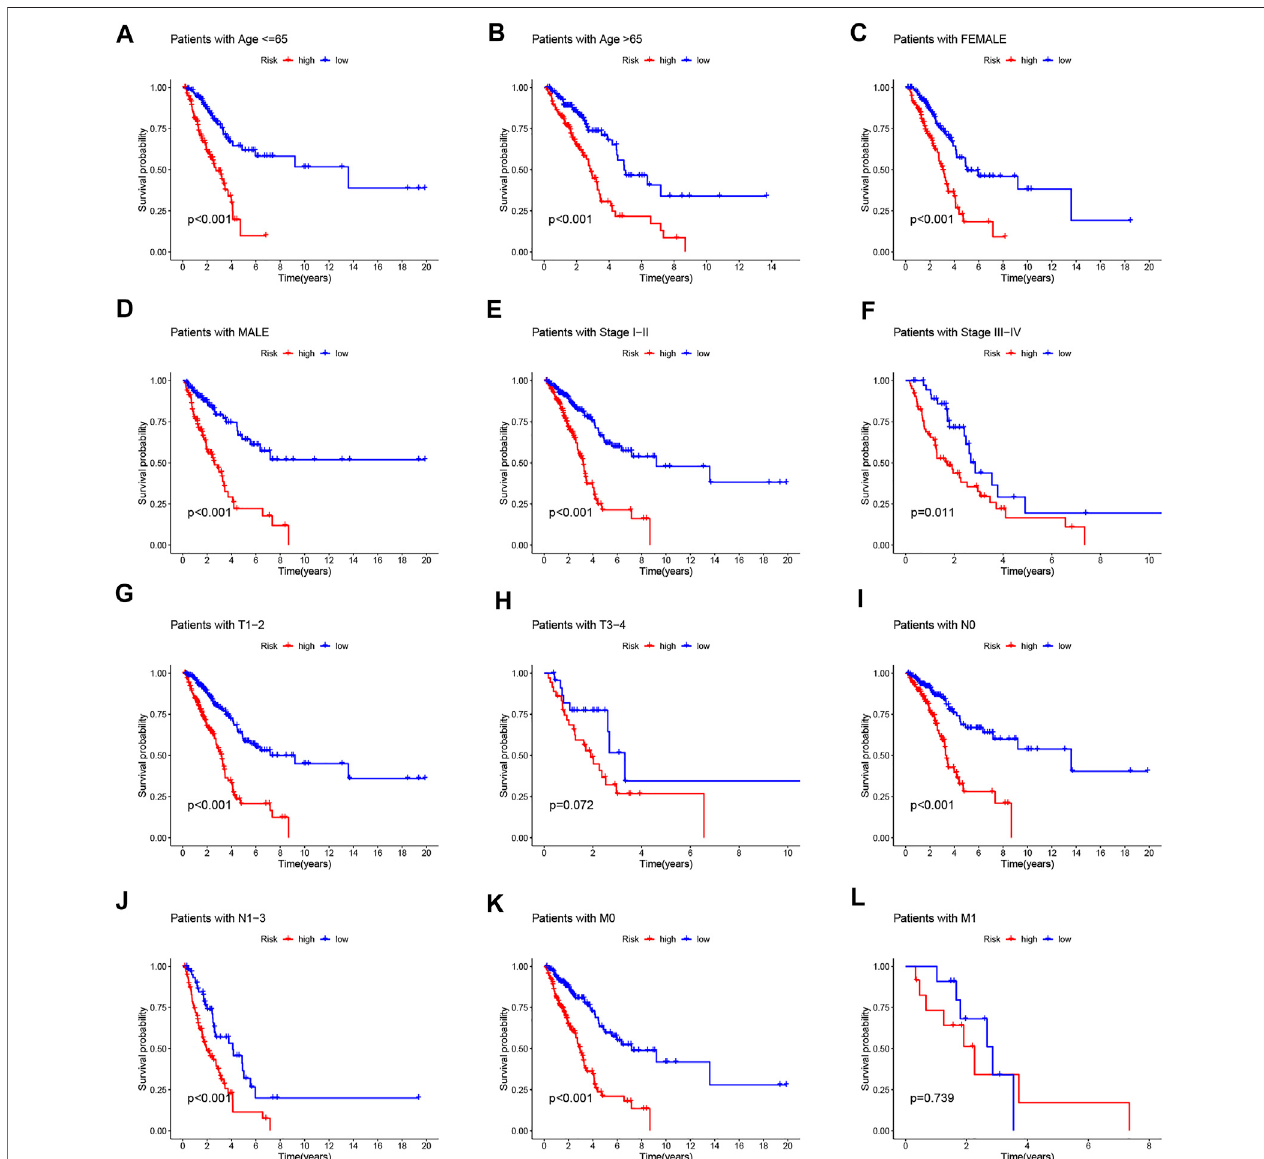
FIGURE 3 | Kaplan – Meier survival curves of low- and high-risk groups sorted by different clinicopathological variables. (A,B) Age, (C,D) sex, (E,F) stage, (G,H) T stage, (I,J) N stage, and (K,L) M stage.